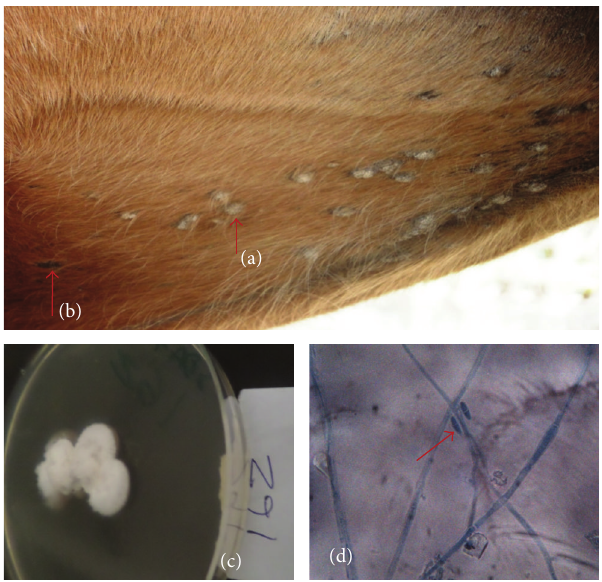
Figure 4: Lesions of dermatophytosis on the hind limb of a horse caused by M. gypseum (a), cream colony of M. gypseum with radial groovesandacentralumbo(b),andmultiple4-celledmacroconidia of M. gypseum in clusters (c).